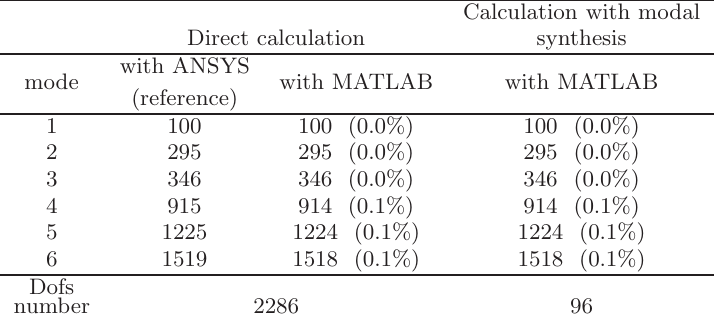
Table 1. The six first natural frequencies of the propeller ( and the relative errors ) (Hz). Calculation with modal